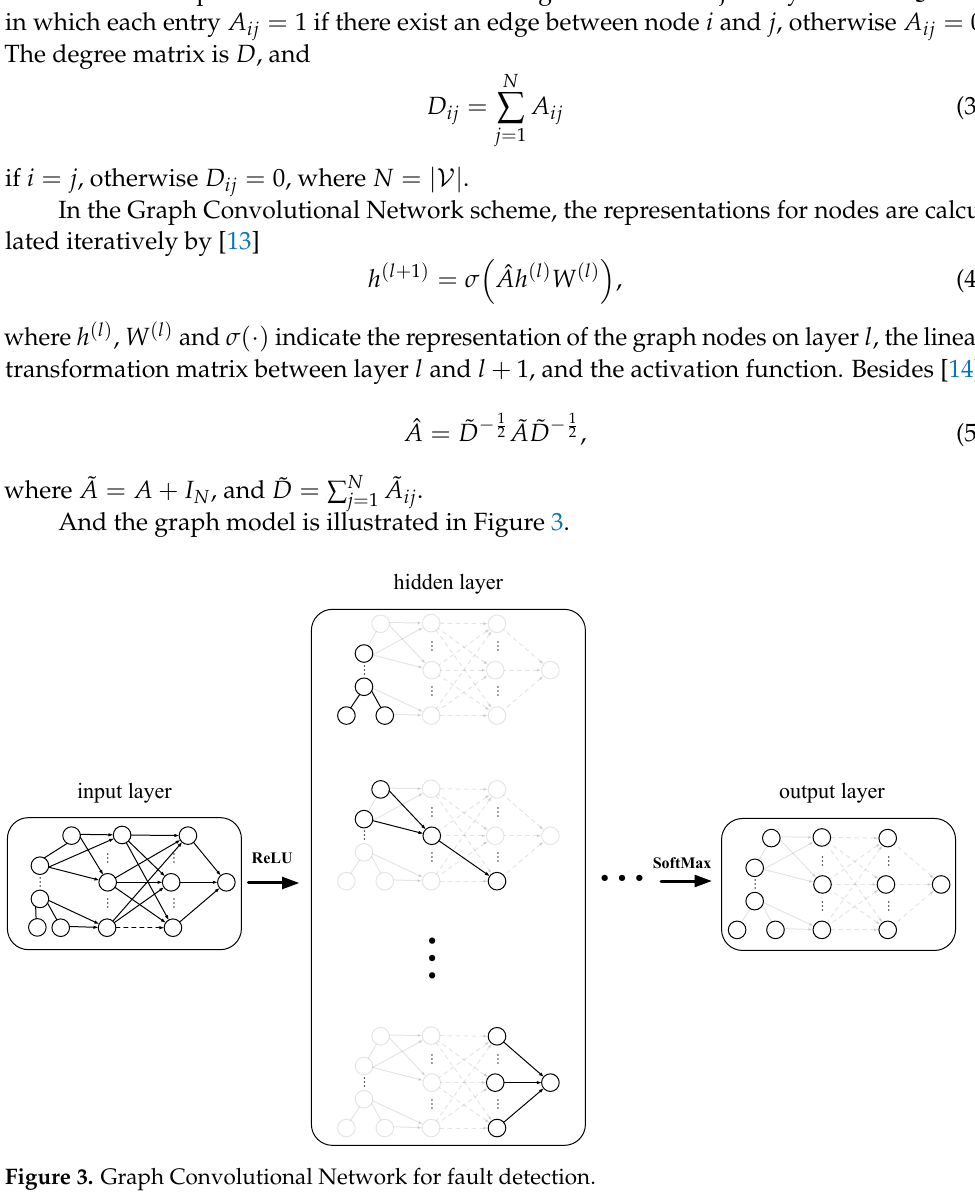
Figure 3. Graph Convolutional Network for fault